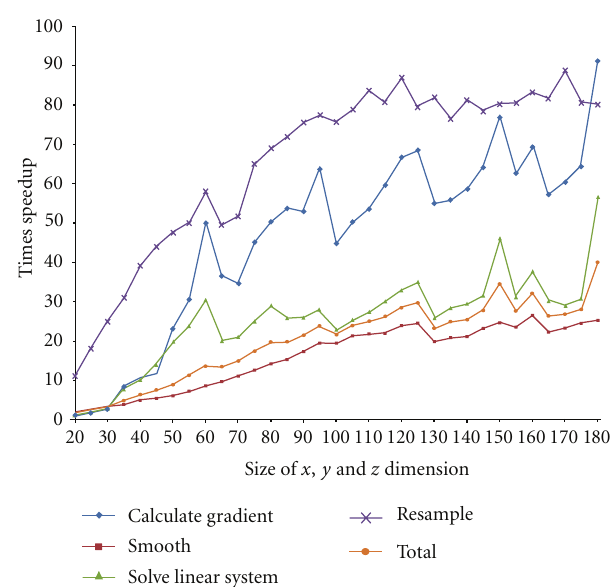
Figure 6: Speed up of the di ff erent components of the motion estimation algorithm for di ff erent size of images on the C1060